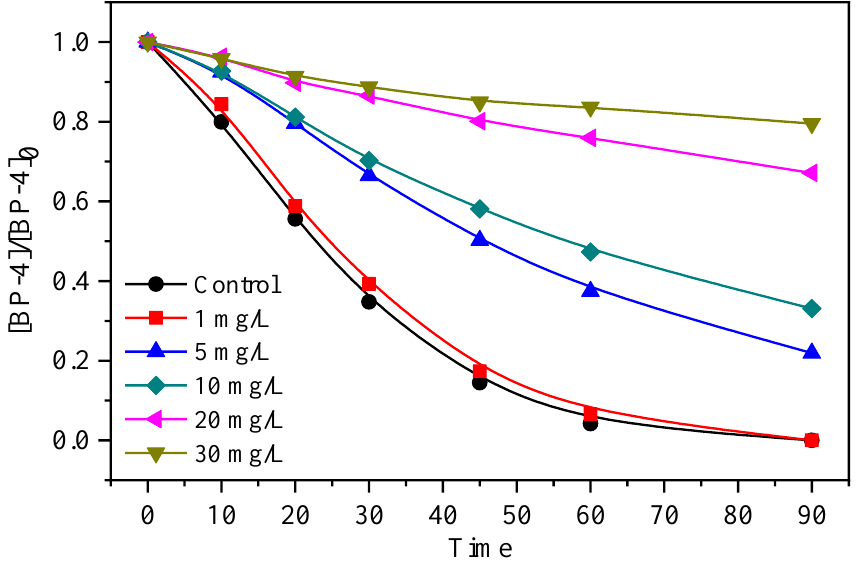
Figure 4. Effect of humic acid (HA) concentration on the removal of BP-4. In Figure 4, when the HA concentration was lower than 1 mg/L, the removal rate of BP-4 did not show an obvious effect due to HA. The removal rate of BP-4 decreased with the increase of concentration of HA. When the concentration of HA increased to 20 mg/L, the removal rate of BP-4 changed from 95.82% to 24.09% in 60 min, and when the concentration of HA reached 30 mg/L, the removal rate of BP-4 was reduced to 16.31%. The main reason was that HA has a variety of functional groups, such as -COOH, -OH, etc. The organic matter with these functional groups could have different chemical reactions with oxidants in water, including ferrates. The HA could be oxidized by FeO 42 − in the reaction solution, and that would reduce its reaction with BP-4. At the same time, the HA could not have been oxidized completely, and its products could also form complexes or be subject to adsorption with the final product Fe(OH) 3 colloid of potassium ferrate, thus competing with BP-4 and reducing the removal rate of BP-4.